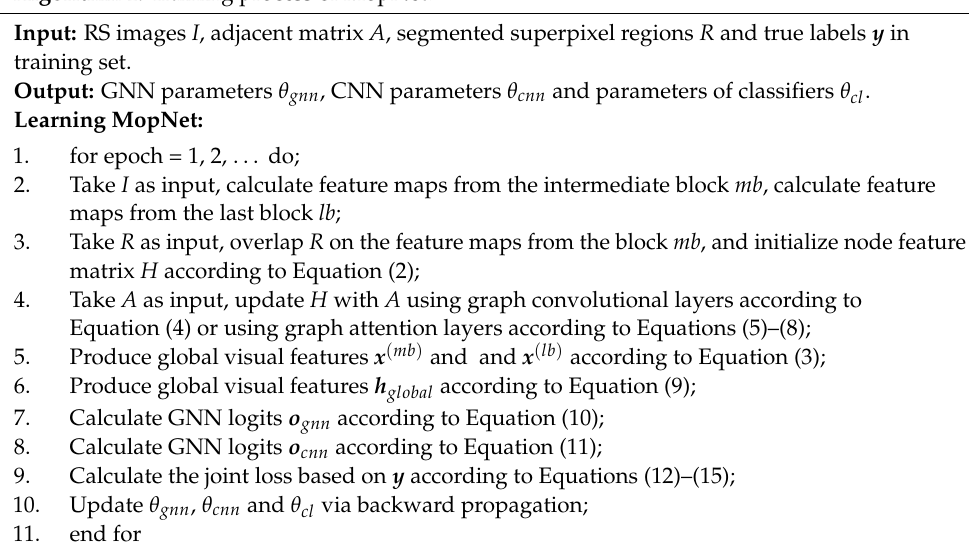
Algorithm 1. Training process of MopNet.